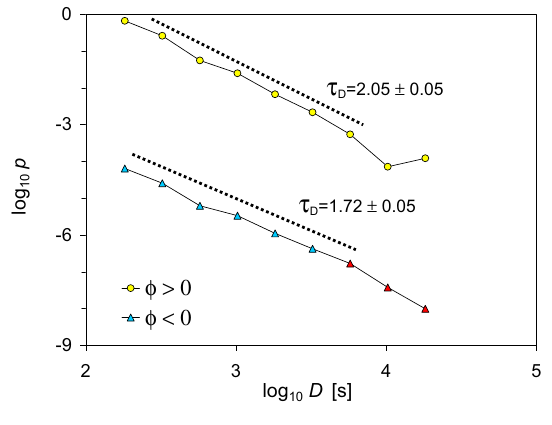
Fig. 6. Normalized occurrence frequency of magnetic latitudes (top) and magnetic local times (bottom) of medium- and large-scale events with E> 5 × 10 11 . Note that the MLT distribution of the low- latitude events peaks in the morning auroral